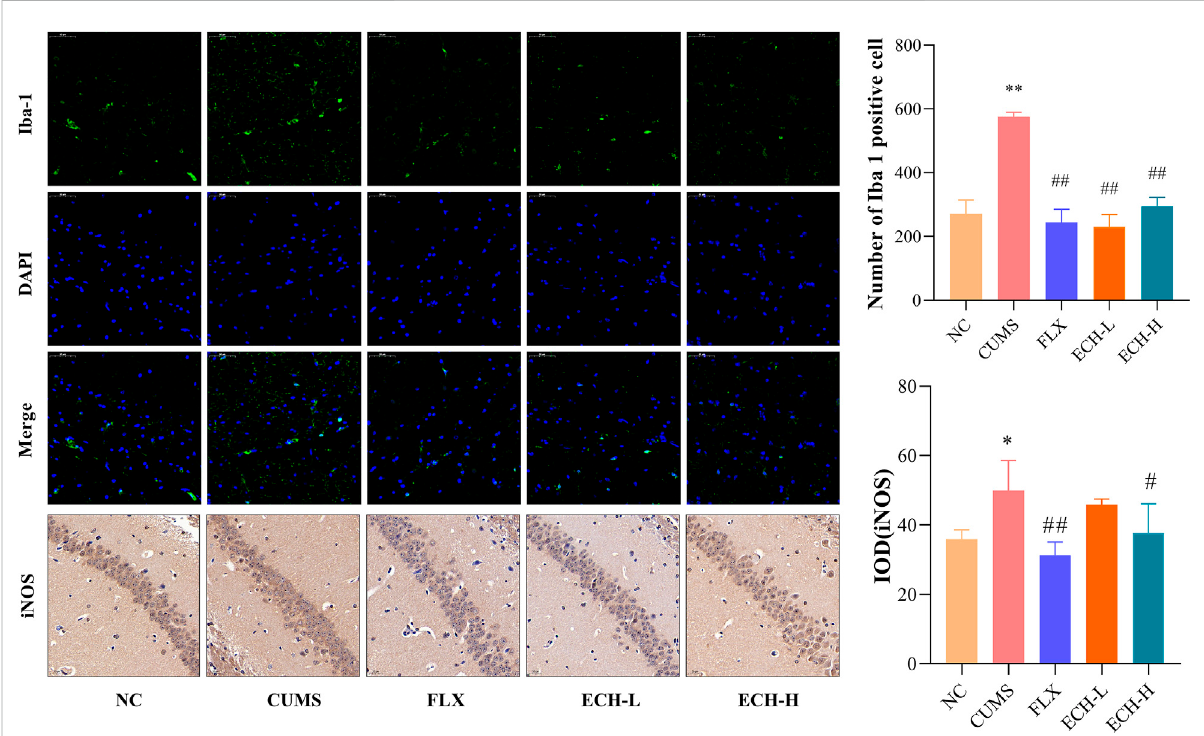
EffectofECHonIba-1andiNOSproteinexpressioninthehippocampusofCUMSMice.NC,un-treatednormalmice;CUMS,miceweretreated with the chronic stimulating factors for 7 weeks to set up the CUMS depression model; FLX, CUMS induced mice were administered with fl uoxetine (10 mg/kg,i.g.) daily for 21 days; ECH-L, CUMS induced mice were administered with echinacoside (15 mg/kg,i.g.) daily for 21 days; ECH-H, CUMS induced mice were administered with echinacoside (60 mg/kg,i.g.) daily for 21 days n = 3/group. * p < .05, ** p < .01 compared with control group; # p < .05, ## p < .01 compared with CUMS